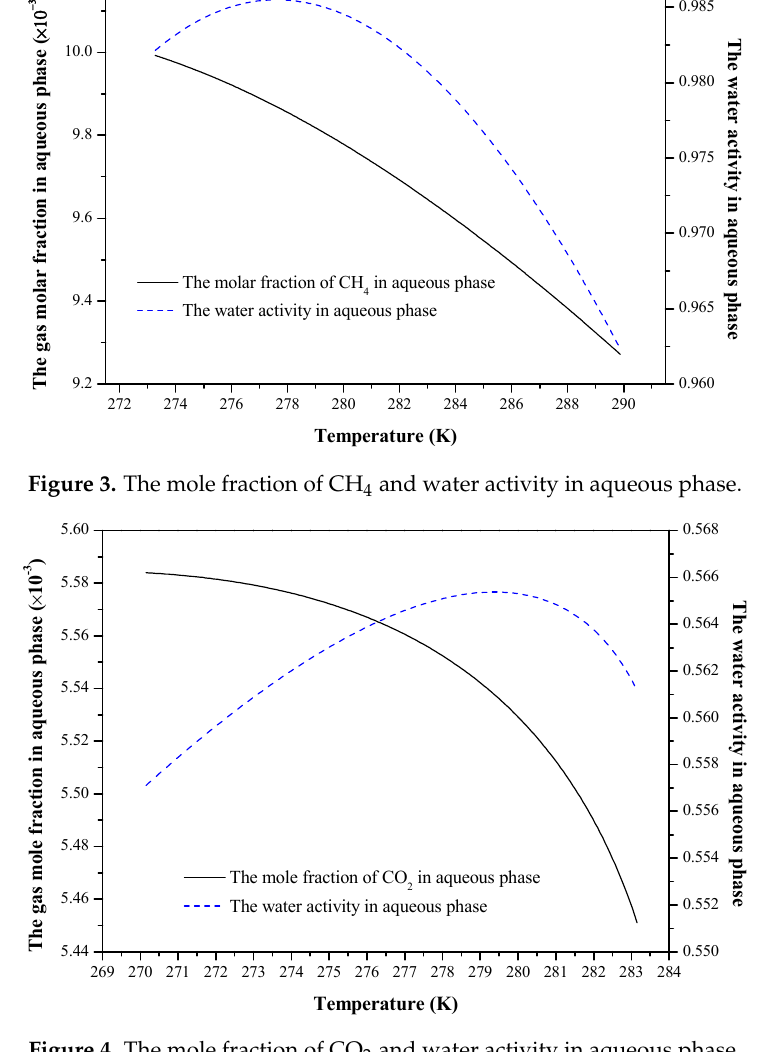
Figure 4. The mole fraction of CO 2 and water activity in aqueous phase.